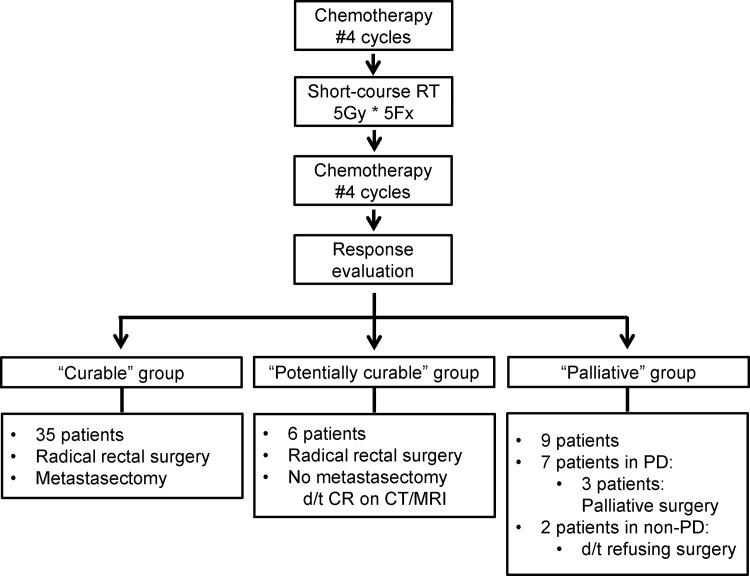
A flowchart depicting the timeline of upfront chemotherapy and short-course radiotherapy with delayed surgery at our institution.